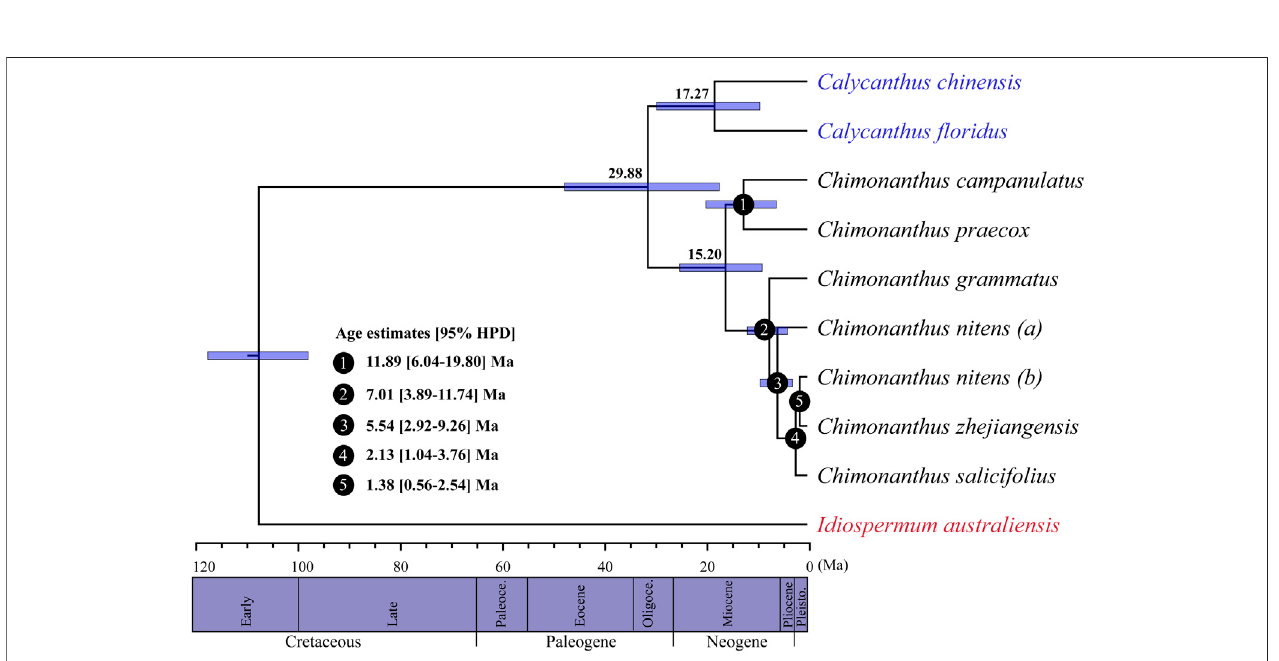
FIGURE 5 | BEAST-derived chronograms of Calycanthaceae based on whole chloroplast genome sequences. Blue bars indicate the 95% highest posterior density (HPD) credibility intervals for node ages (Ma). Estimated divergence times of Chimonanthus species are indicated at the nodes (nodes 1 – 5).